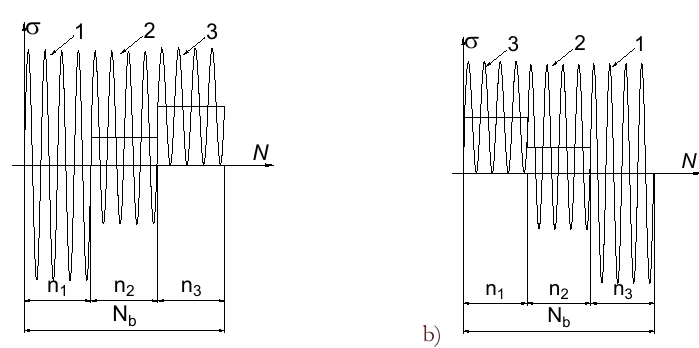
Figure 4: Block loading applied in fatigue tests: a) for increasing mean load value, b) for decreasing mean load value.